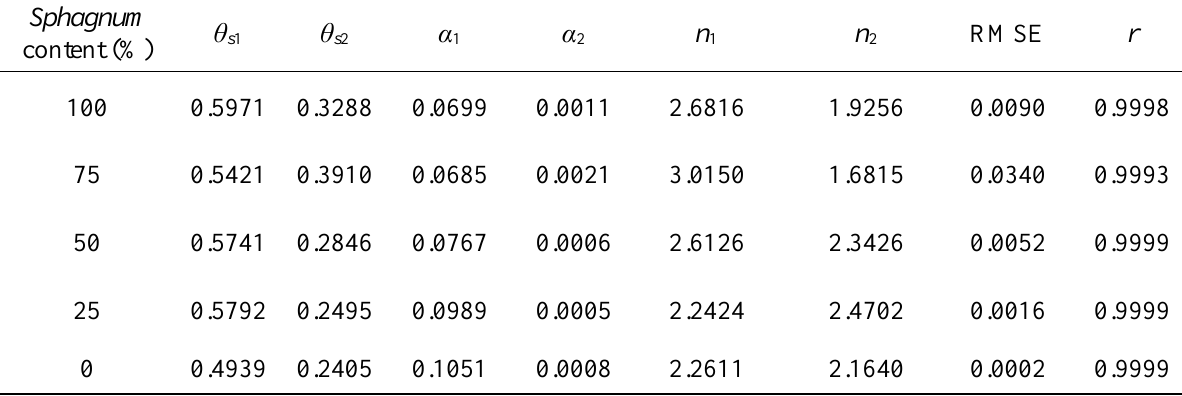
Figure 9. Measured water retention values and estimated drying curves for mixtures of Sphagnum and peat at matric suctions ranging from 2.5 to 15,000 hPa. The curves were obtained by fitting the double van Genuchten equation (van Genuchten 1980). The percentage (dry mass basis) of Sphagnum fuscum dominated biomass included in each mixture (compressed to BD ~72 kg m -3 ) is shown in the legend. Error bars denote ± SD for measured points. Table 4. The double van Genuchten parameters and fitting values for all experimental mixtures. Curves were fitted to average values for three replicates and seven matric potentials. RMSE = root mean square